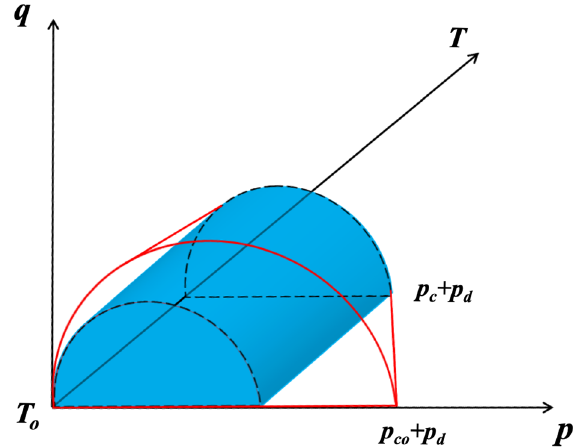
Figure 3. Schematic representation of the effect of temperature on sediment yield surface.